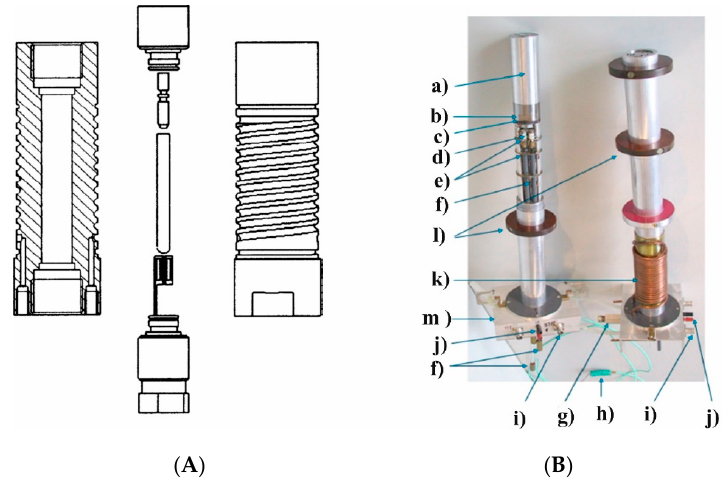
Figure 8. ( A ) Cross-sectional view of the high-pressure autoclave with top and bottom plug, sample tube, macor plug and sample coil. ( B ) Photograph of two narrow bore probe heads: (a) aluminum jacket sealing the double helix used for thermostating, (b) high-pressure vessel, (c) platform carrying the autoclave, (d) capacitors, (e) capacitor platforms, (f) tuning rods, (g) high-pressure connector, (h) thermocouple, (i) BNC connector, (j) Pt-100 connector, (k) copper tubing, and (l) wide-bore adapter. Reproduced from Reference [24], with the permission of AIP Publishing.